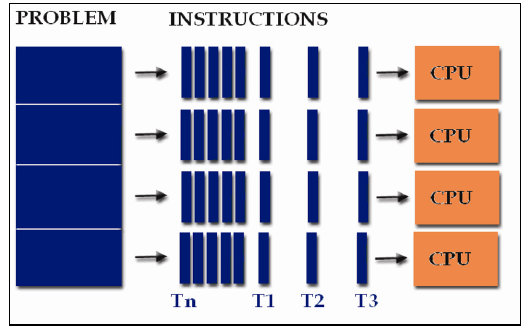
Fig. 1. Schematic representation of Parallel Computing